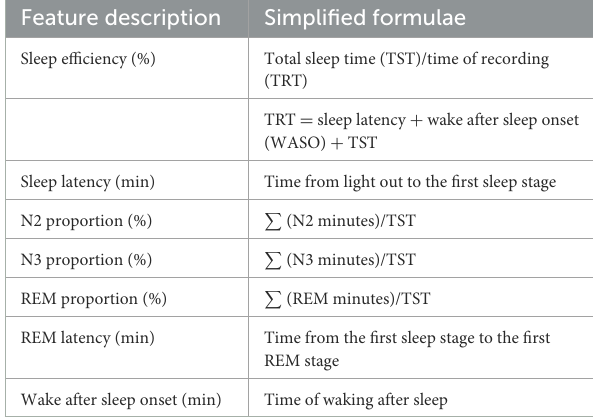
TABLE 2 Objective sleep quality